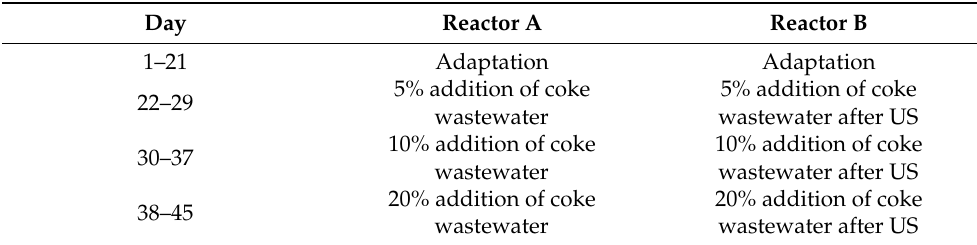
Table 4. Duration of the individual reactor operation